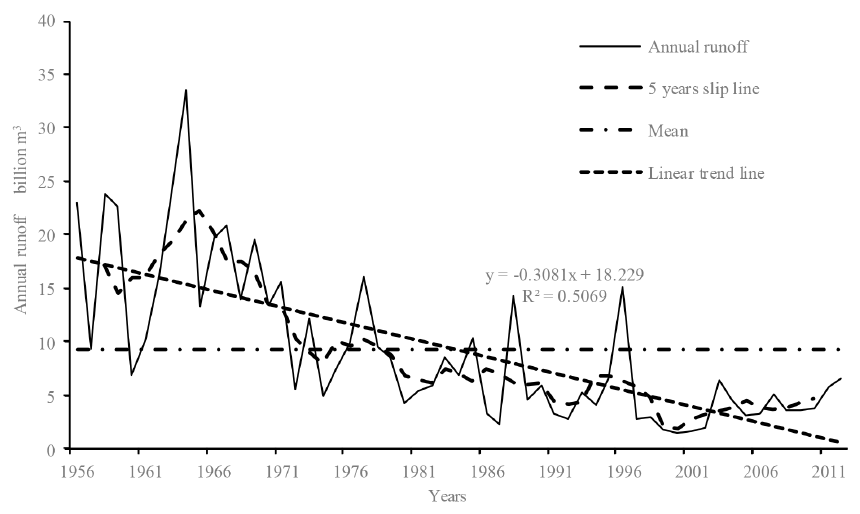
Figure 4. Trend of annual average runoff in Hejin station. Table 1. The results of runoff diagnosis in Hejin station.